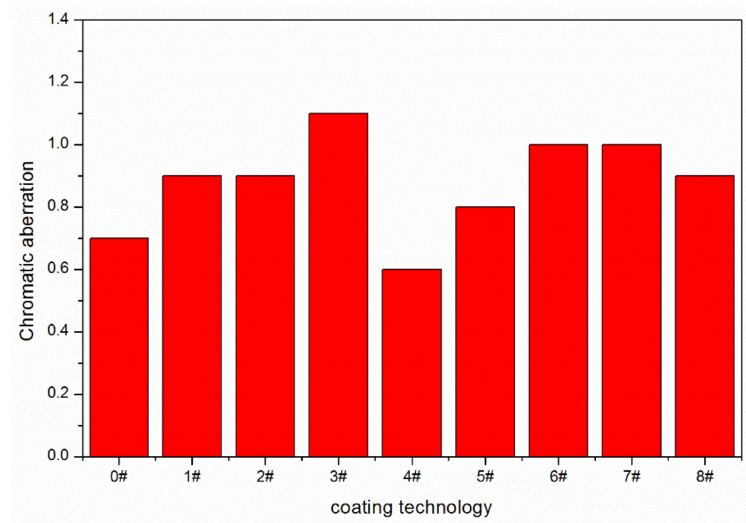
Figure 4. Chromatic aberration of coating film under different coating technologies.